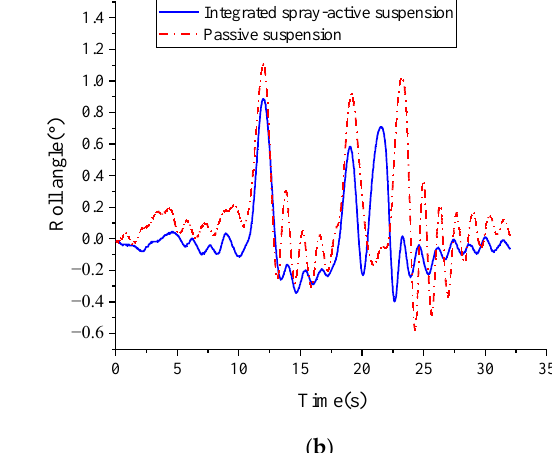
Figure 13. ( a ) Pitch angle comparison curve of wheel-crossing obstacle on one side; ( b ) roll angle comparison curve of wheel-crossing obstacle on one side.